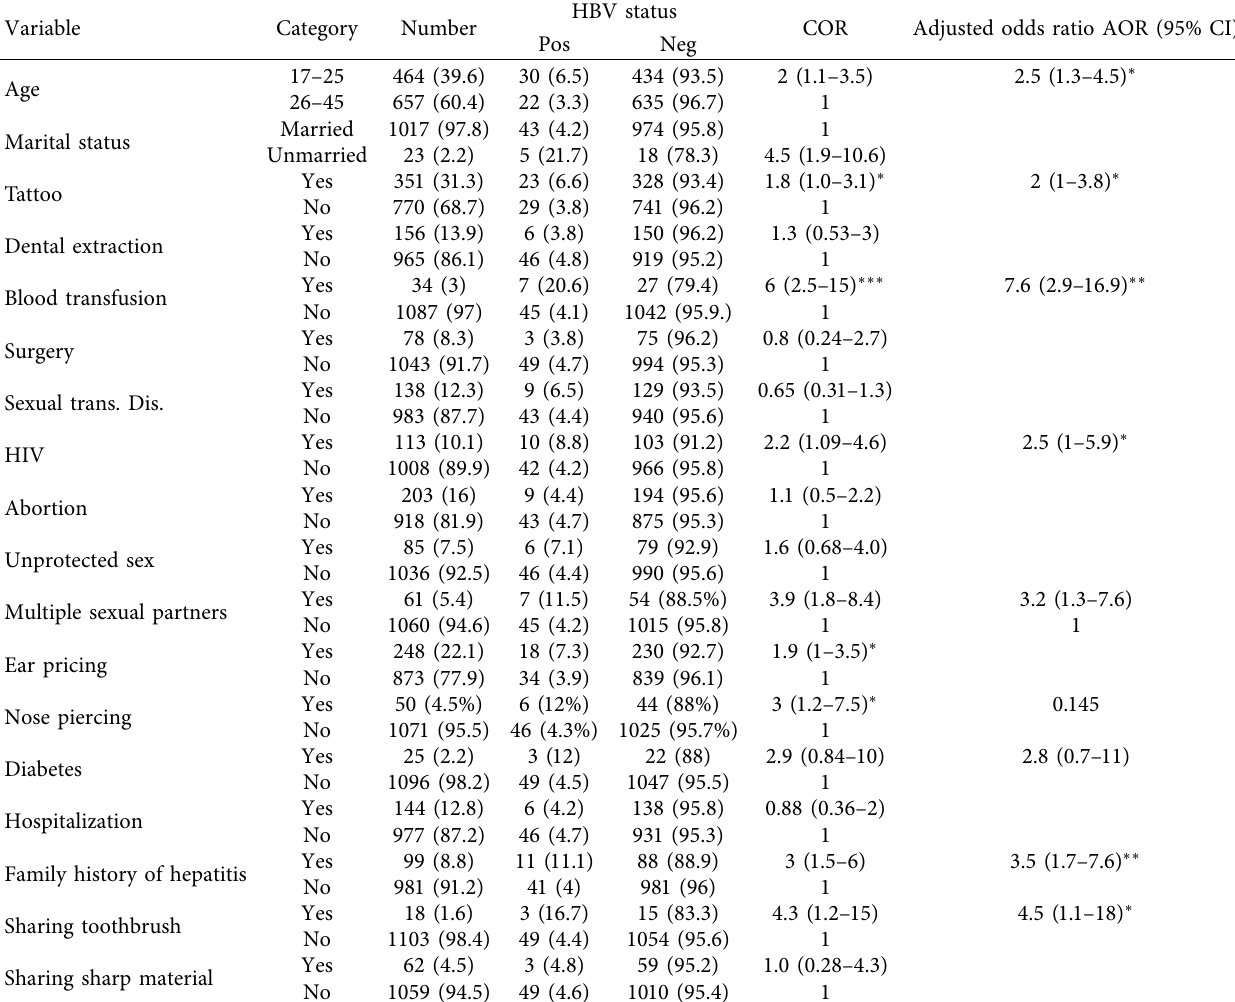
Table 4: Bivariate and multivariate analysis of factors associated with HBV infection among pregnant women in the Amhara national regional state tertiary hospitals from May 1, 2018, to September 30, 2019.